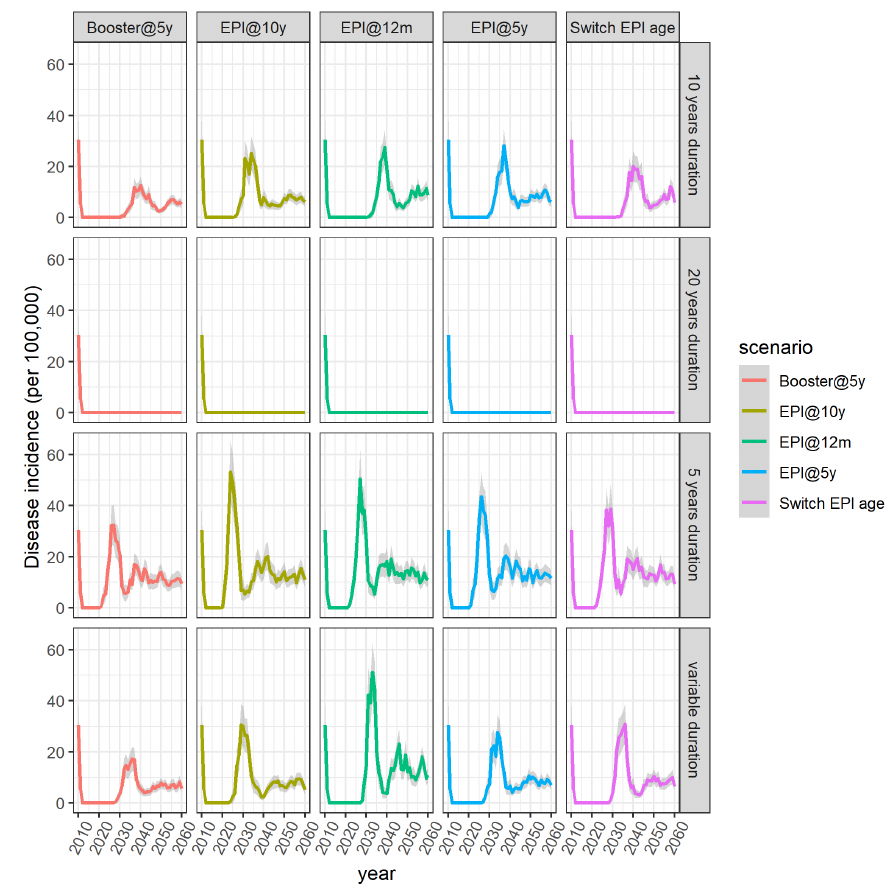
Figure 1. Average disease incidence across the different vaccination scenarios and across the different assumptions regarding the duration of vaccine-induced protection. Shaded areas represent the 95% confidence intervals.